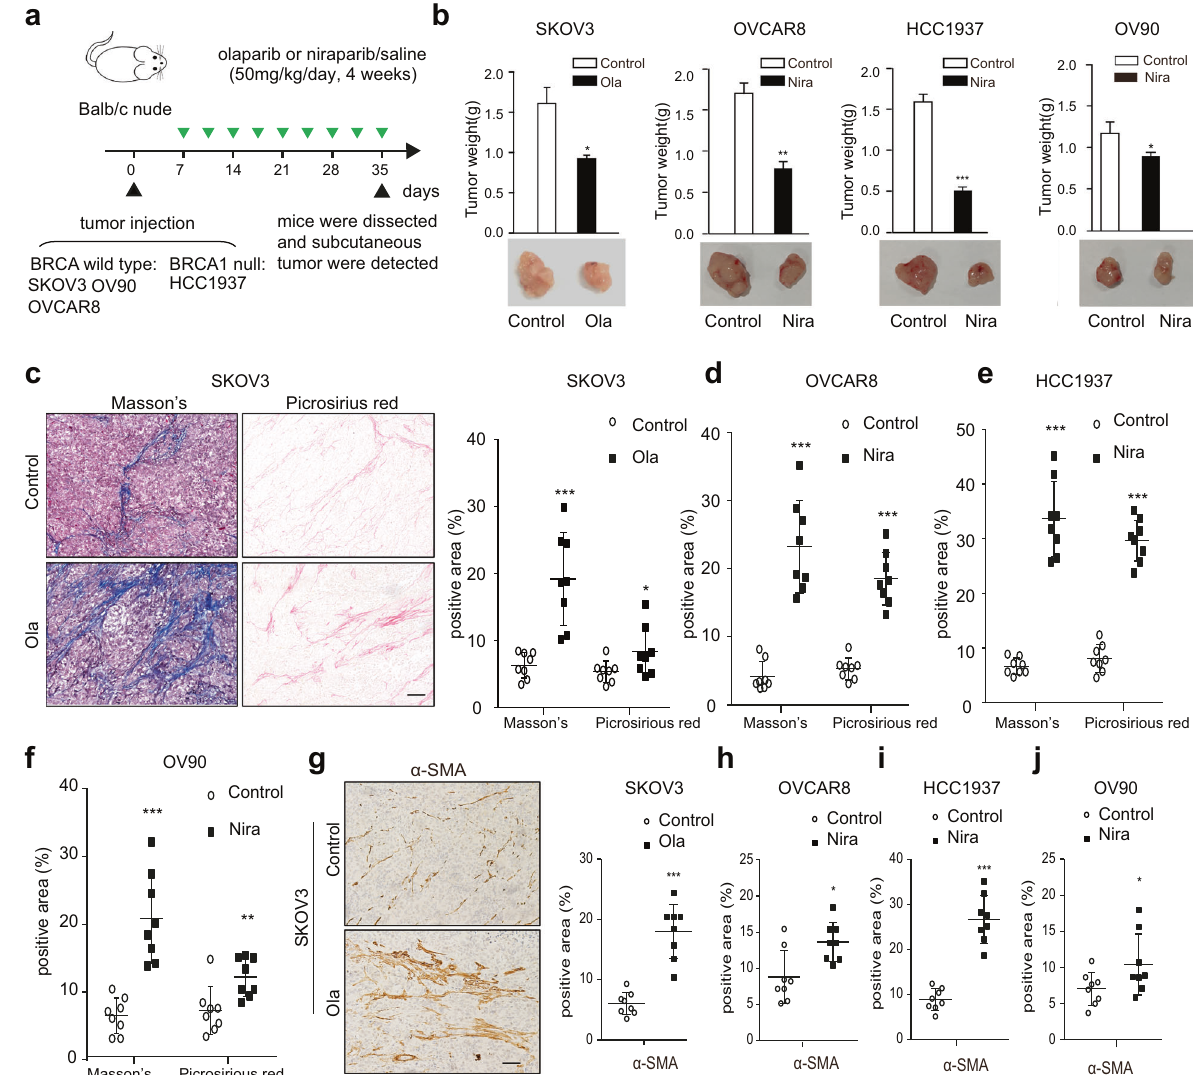
Fig. 3 PARPis promote the activation of OC stromal fi broblasts in vivo. a The schematic diagram of subcutaneous tumor models evaluating the effect of Ola or Nira on OC stroma in vivo. b Representative images and weight quanti fi cation of subcutaneous tumors from mice ( n = 8) bearing SKOV3, OVCAR8, HCC1937, and OV90 cells in the control and Ola or Nira-treated groups. c – f Representative photographs and quanti fi cation of Masson ’ s trichrome and picrosirius red staining showing the contents of stromal and collagen deposition in SKOV3, OVCAR8, HCC1937, and OV90 xenografts. Measures were taken from different samples ( n = 8). Scale bar, 50 µm. g – j Representative IHC images and quanti fi cation of α -SMA in the Ola or Nira-challenged tumor stroma and the control stroma. Measurements were taken from distinct samples ( n = 8). Scale bar, 50 µm. Data are expressed as mean ± s.e.m., * p < 0.05; ** p < 0.01; *** p <